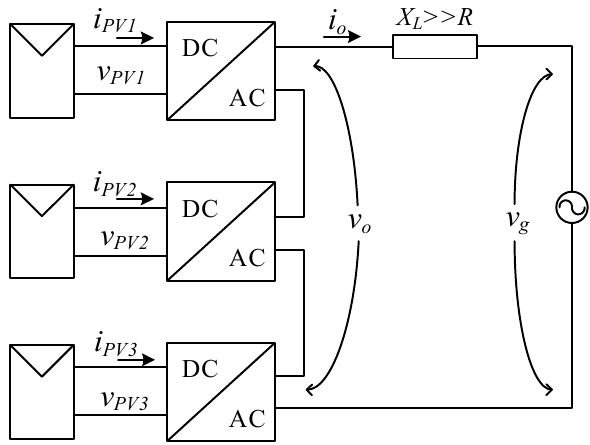
Figure 2. General schematic of a PV system grid connection using a seven levels CHB-ML inverter.